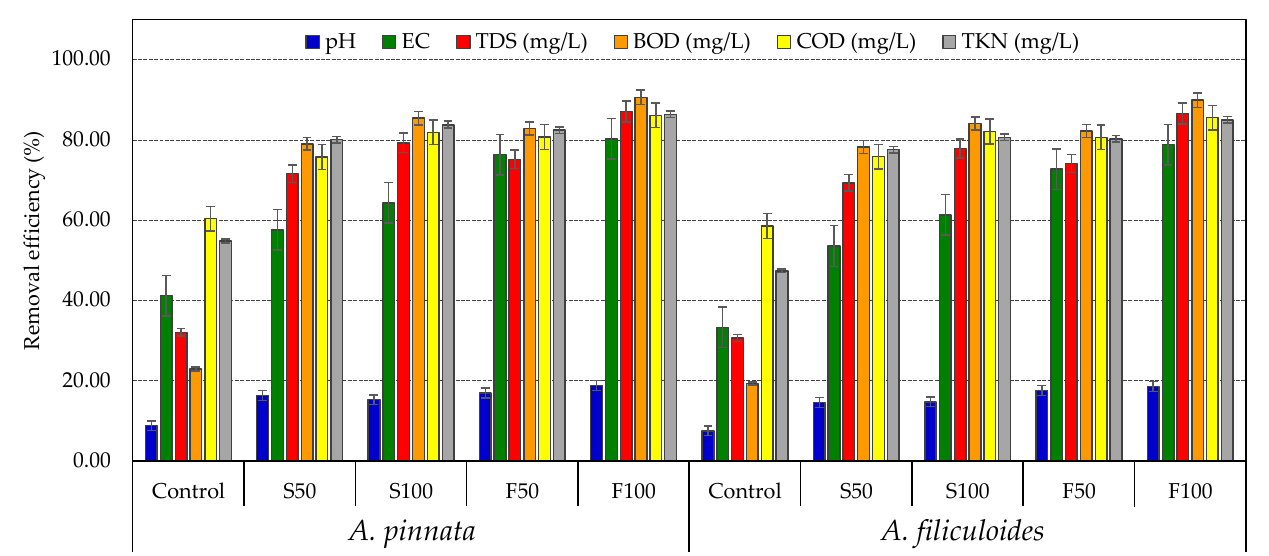
Figure 3. Pollutant removal efficiency of two Azolla spp. cultivated in different treatments of MFW (S: stagnant; F: flowing reactor).